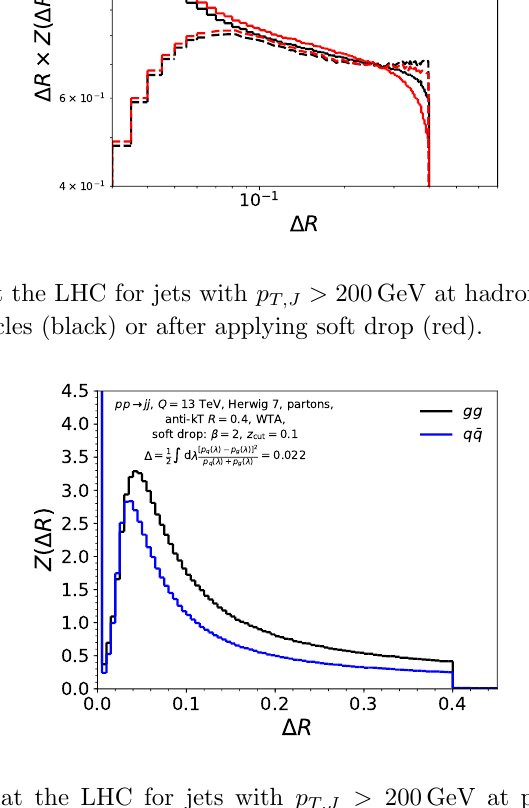
! q (cid:22) q T;J > 200 GeV at parton level for pp